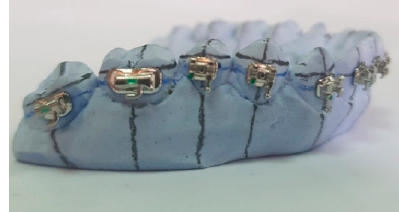
Figure 3: Custom composite resin base attachment group (CBA).